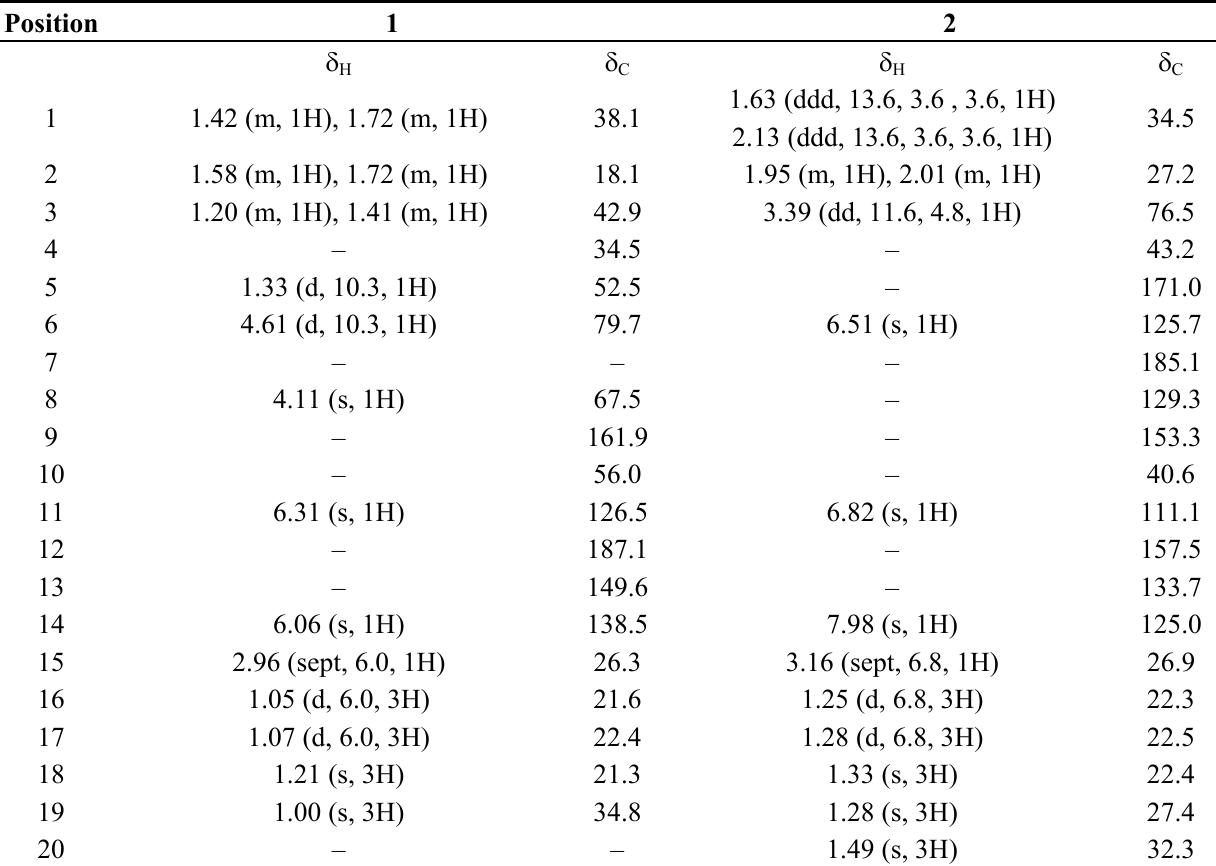
Table 1. 1 H- (400 MHz) and 13 C-NMR (100 MHz) data (CDCl Chemical shifts  in ppm relative to TMS, J in Hz.